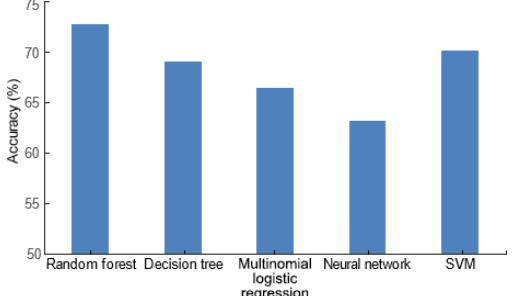
Fig. 5 Performance comparison of random forest model with other models in death cases prediction.